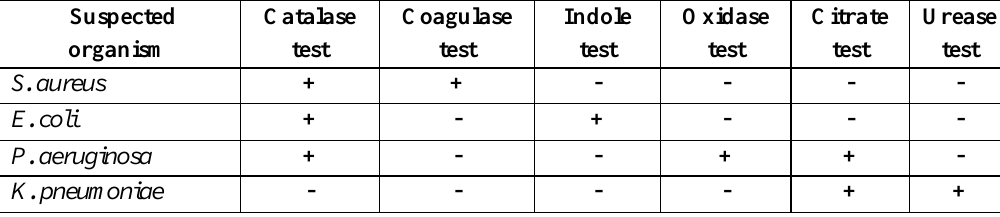
Table 2. Results of biochemical